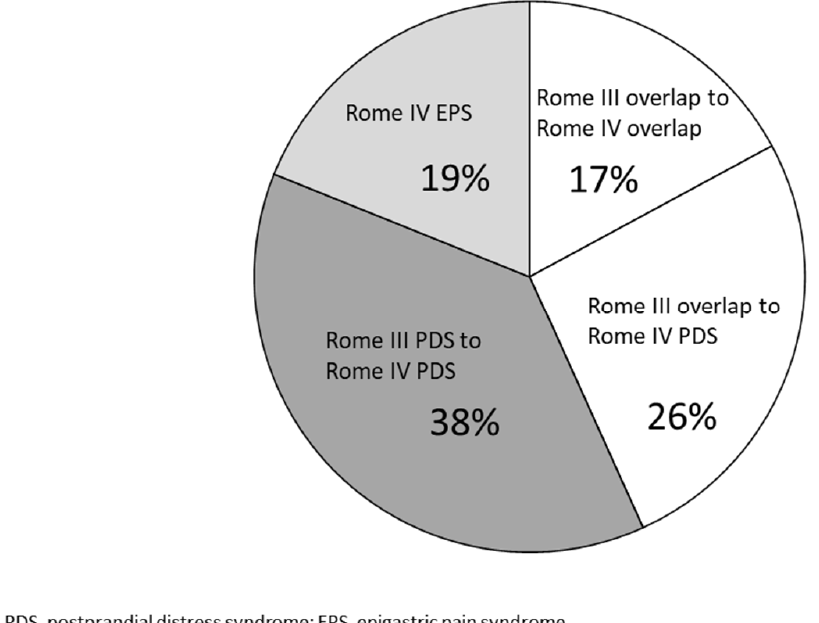
Figure 3. Combination of the Rome III and IV criteria. Overlap to PDS: patients whose diagnosis was changed from overlap of EPS and PDS in the Rome III criteria to PDS in the Rome IV criteria. PDS to PDS: patients diagnosed with PDS in both the Rome III and IV criteria. Overlap to overlap: Patients diagnosed with overlap in both the Rome III and IV criteria. Table 2. Characteristics and symptoms between the Rome III and IV criteria.